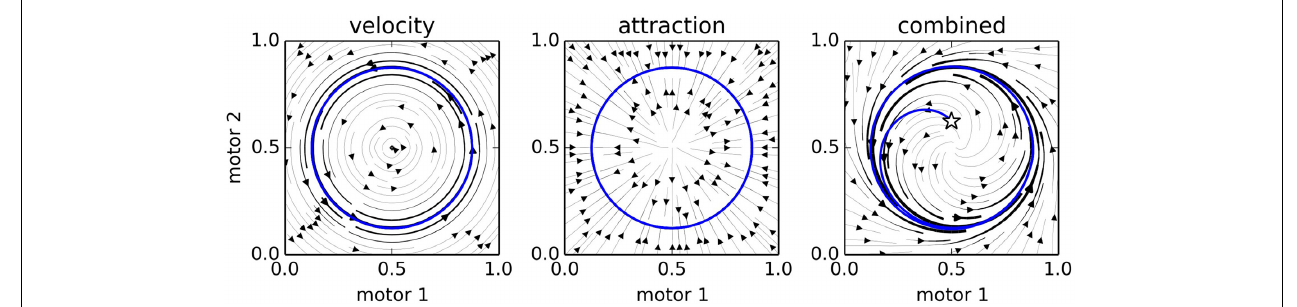
FIGURE 4 | Three snapshots of the 2-Motor IDSM as a fixed dynamical system. The left plot indicates the influence of the velocity term, the central plot indicates the influence of the attraction factor, and the right plot indicates